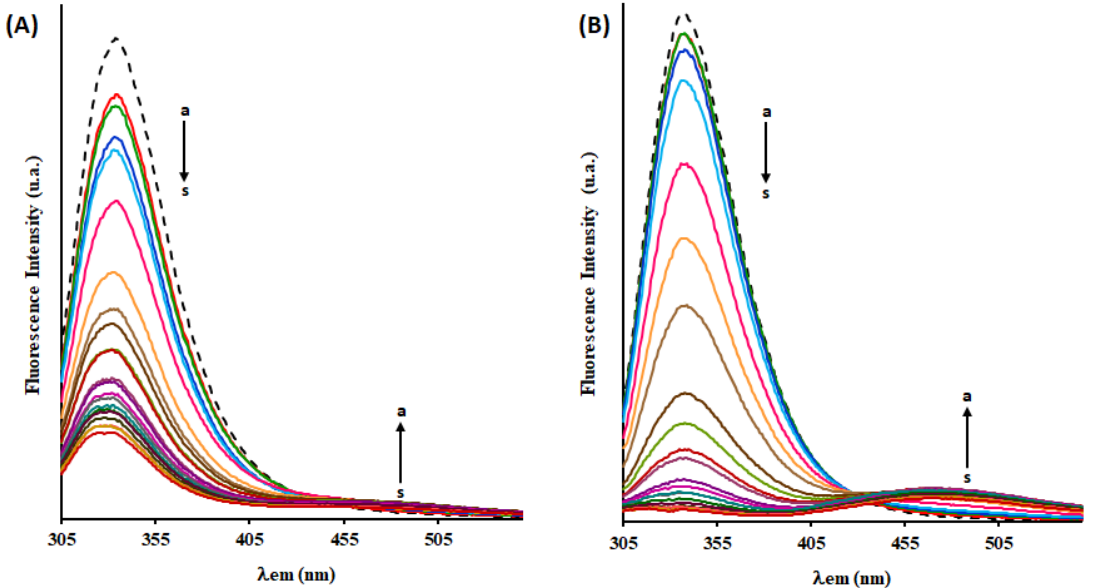
Figure 5. Fluorescence emission spectra of [Ru( η 5 -C 5 H 5 )( m TPPMS)(bopy)][CF 3 SO 3 ]-HSA ( A ) and [Ru( η 5 -C 5 H 5 )( m TPPMS)(bopy)][CF 3 SO 3 ]-HSA faf ( B ). The concentration of HSA/HSA faf was 2.5 mM (a) and that of [Ru( η 5 -C 5 H 5 )( m TPPMS)(bopy)][CF 3 SO 3 ] was increased from 0 to 45 μM (b → s), with increments of 2.5 μM; 10 mM HEPES buffer, pH 7.4, incubation at 37 °C during 24 h. Each color represents an HSA:Ru ratio (a → s).